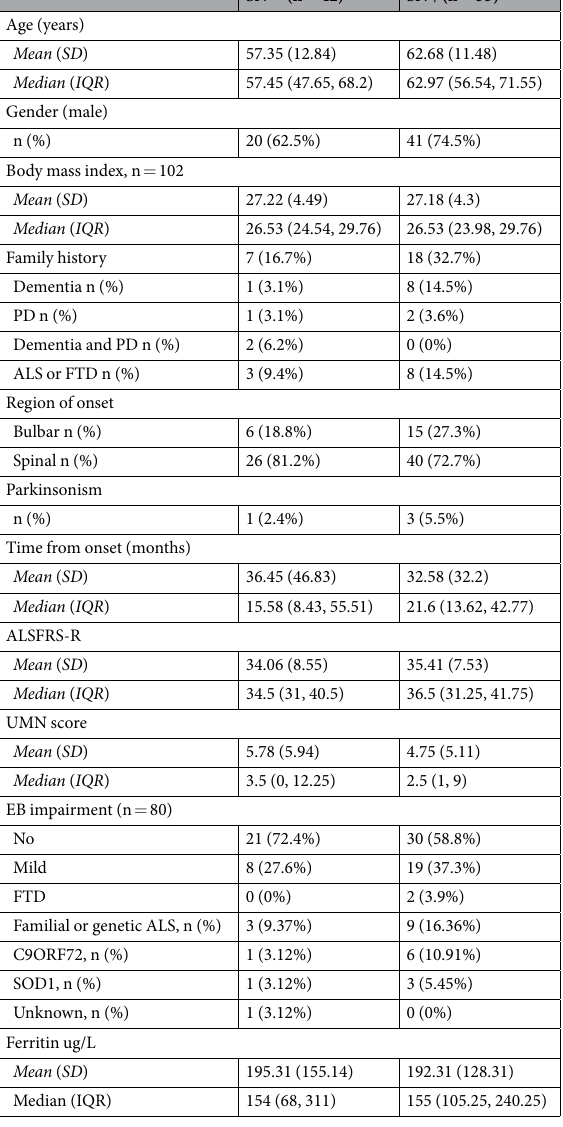
Table 3. Demographical, clinical and analytical characteristics of ALS patients classified according to the predefined threshold of SNh area (0.22 cm 2 ). ALS: amyotrophic lateral sclerosis; BMI: body mass index; EB: executive or behavioural; FTD: frontotemporal dementia; PD: Parkinson’s disease; SNh: hyperechogenicity of the substantia nigra; SN + : area of hyperechogenicity of one substantia nigra > 0.22 cm 2 ; SN − : area of hyperechogenicity of both substantia nigra ≤ 0.22 cm 2 ; UMN: upper motor